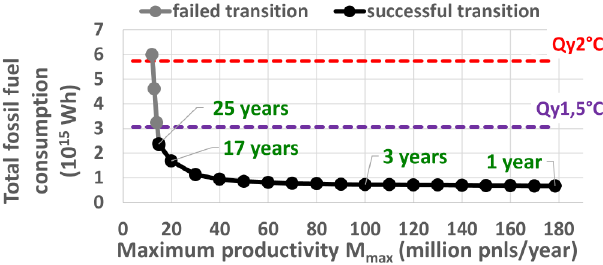
Fig. 4. Total fossil fuel consumption of runs with varying maximum productivity M max , with t f = 100 years. Each dot corresponds to a run with a specific M max . Gray and black dots correspond respectively to failed and successful energy transition along with its duration (in green). Dashed lines represent power generation carbon budget of France to maintain global warming below 1 . 5 ◦ C (in purple) and 2 ◦ C (in